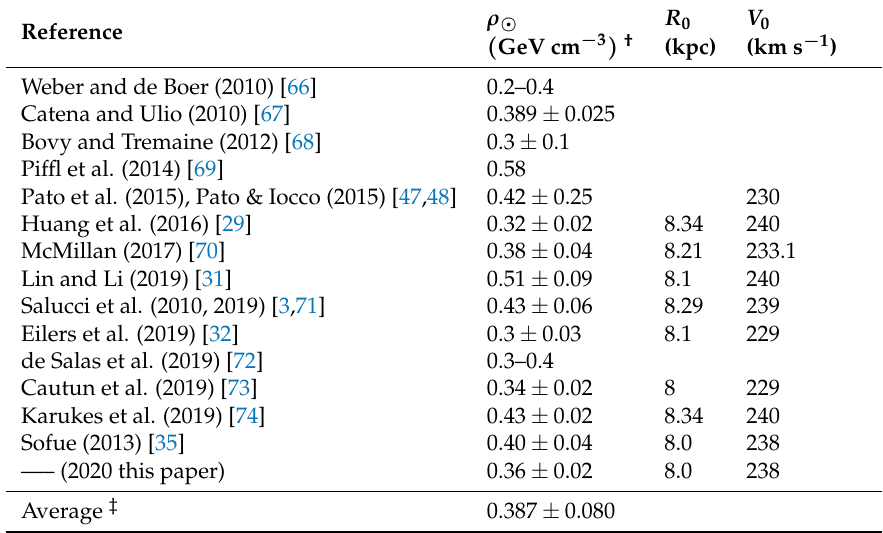
Table 4. Current determinations of the local DM density and the